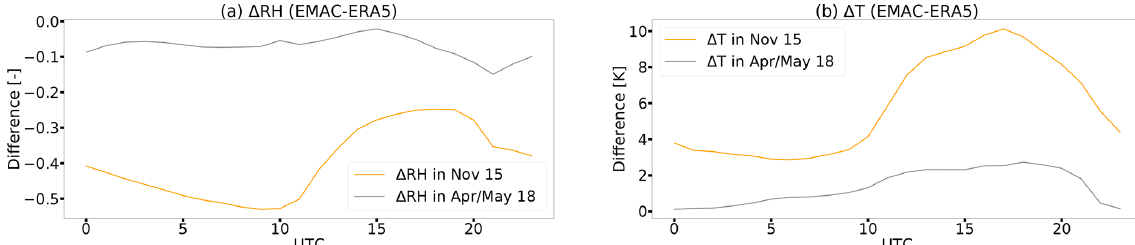
Figure B3. Differences of meteorology between EMAC and ERA5 at ATTO.